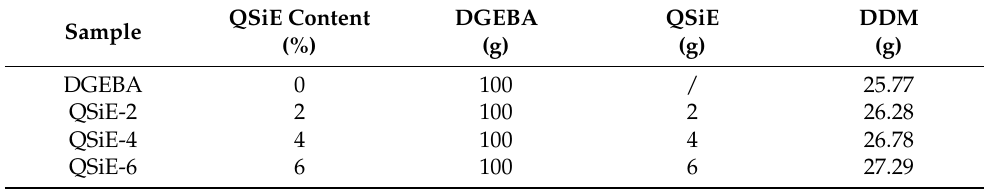
Table 3. The specific formulas of cured